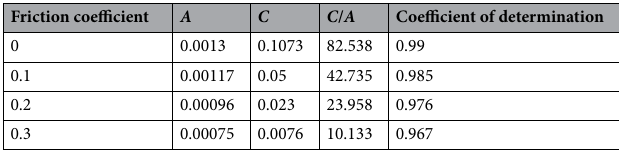
Table 4. The A and C values under different friction